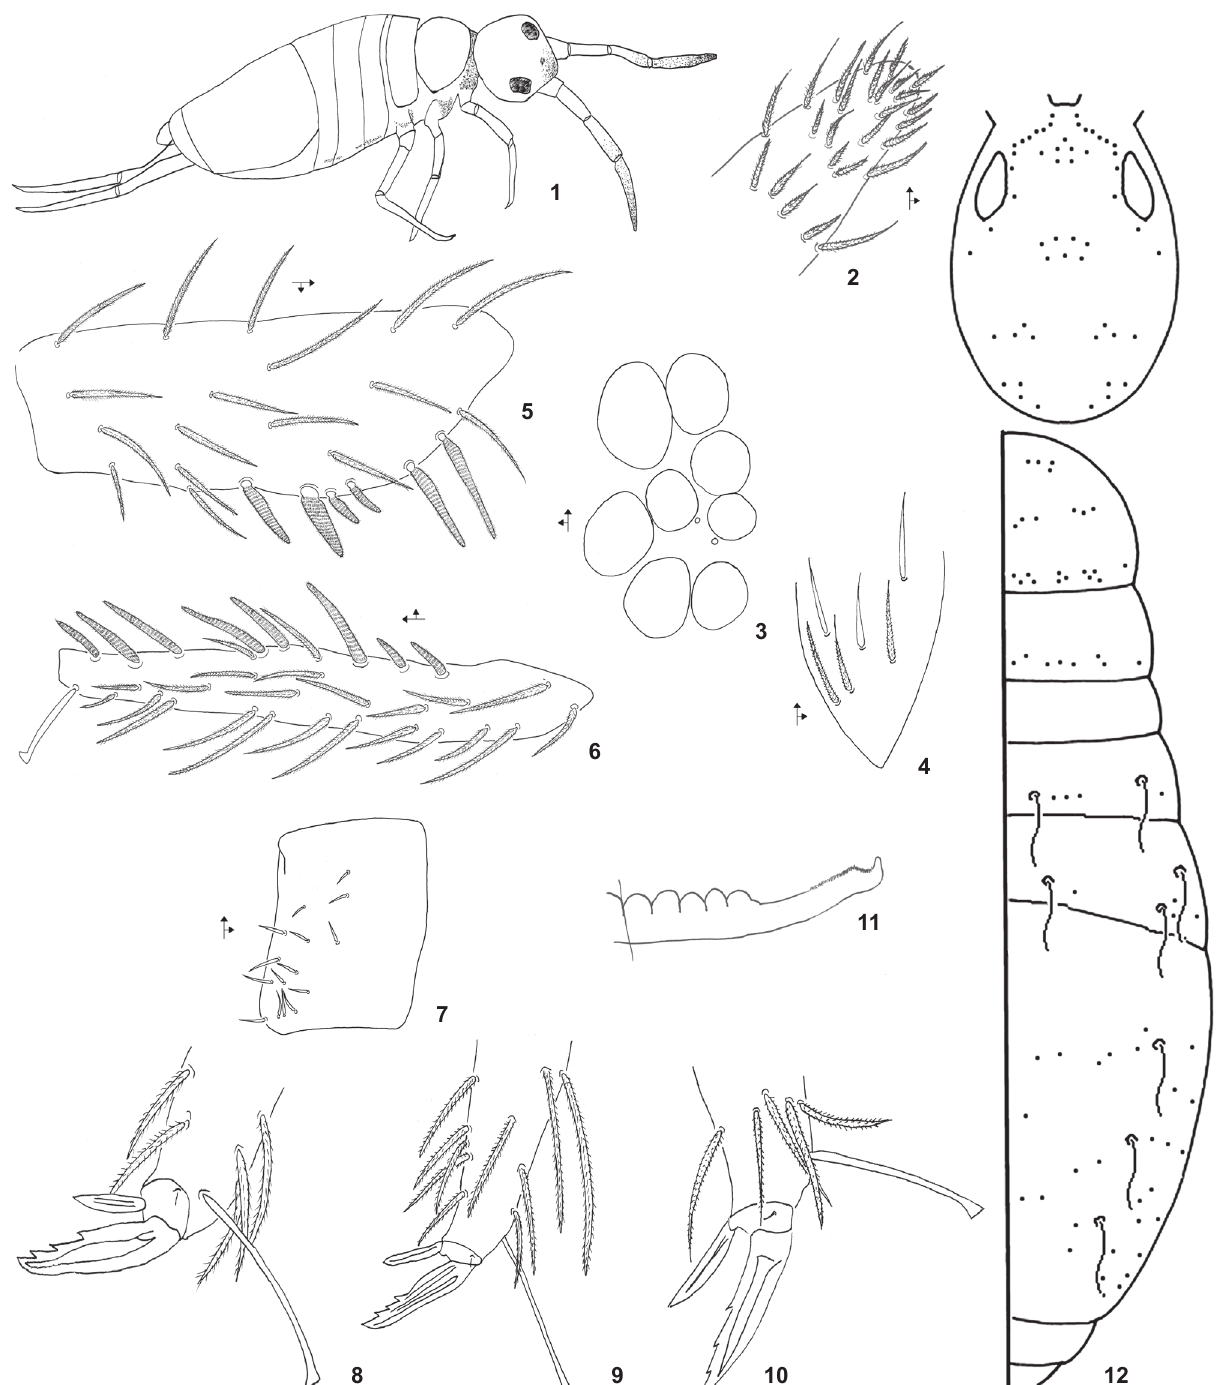
Figures 1-12. Tyrannoseira diabolica sp. nov. : (1) habitus; (2) apical bulb of the 4 th antennal segment; (3) left eyepatch; (4) setae of the labial triangle (right side); (5) male anterior femur; (6) male anterior tibiotarsus; (7) trochanteral organ; (8) first foot complex; (9) second foot complex; (10) third foot complex; (11) distal dens and mucro; (12) dorsal chaetotaxy of second and third abdominal ZOOLOGIA 29 (1): 81–84, February, 2012